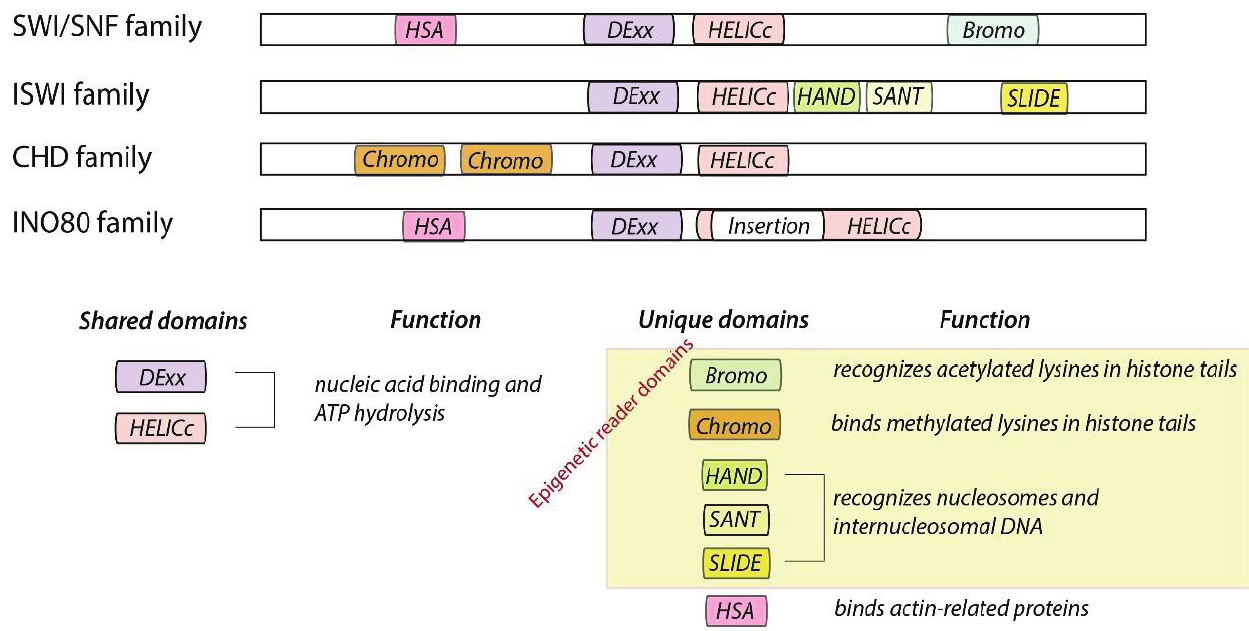
Figure 1. Organization of remodeler families defined by their catalytic and flanking